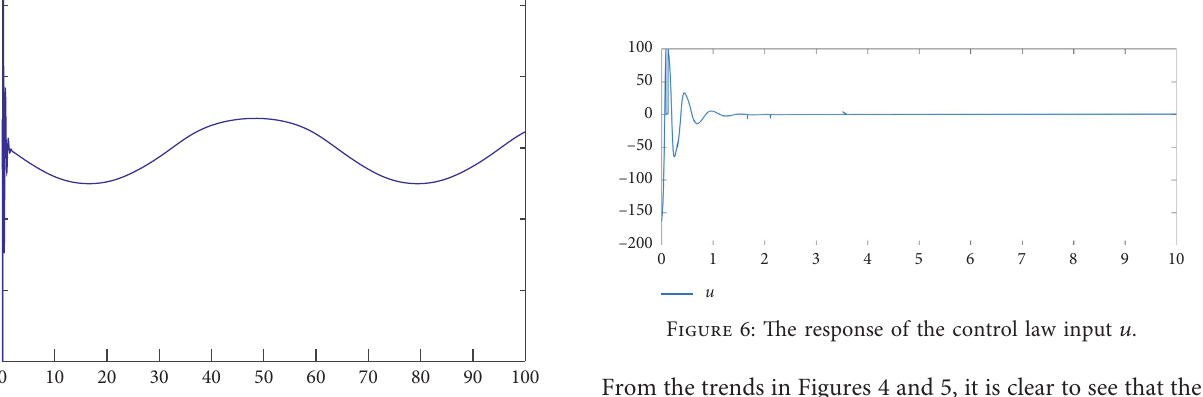
of the example. 2